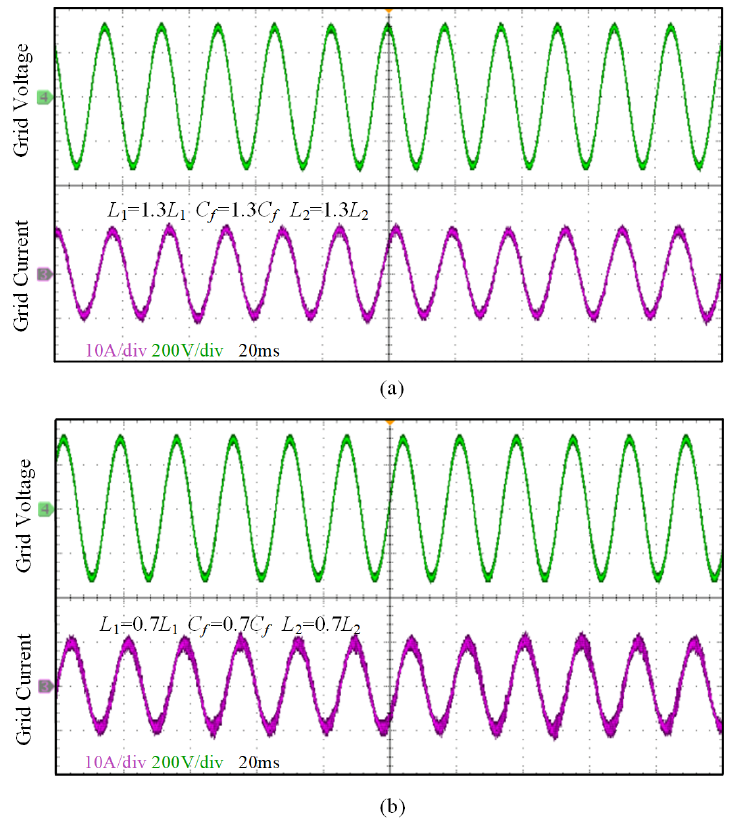
Figure 18. Waveform of grid-connected current when the LCL filter parameters are perturbed: ( a ) filter parameter is increased by 30%; ( b ) filter parameter is decreased by